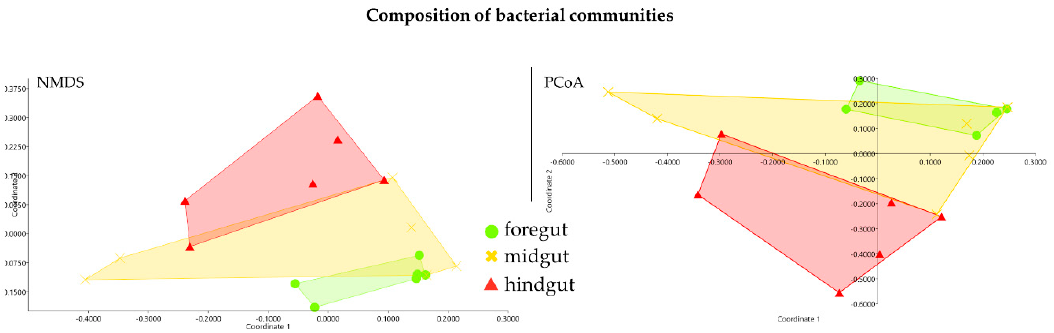
Figure 5. Ordination plots showing composition of bacterial communities in the intestinal tracts. Non- metric multi-dimensional scaling (NMDS) and principle coordinated analysis (PCoA) based on Bray– Curtis dissimilarity matrix were used for all samples. Calculations of dissimilarity were based on relative abundances of OTUs. Sample points were shaped by gut composition.